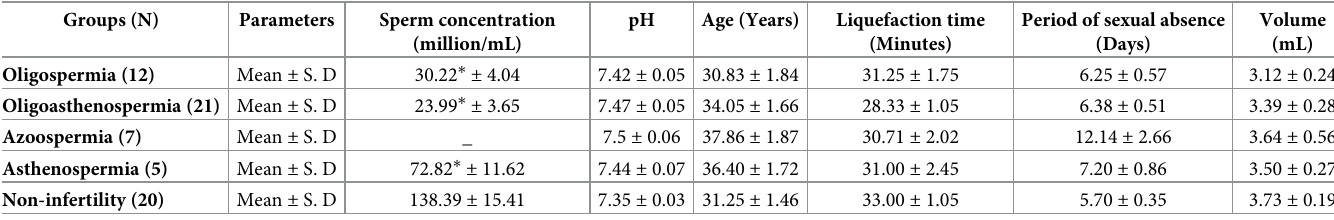
Table 2. Statistics of semen parameters for Infertile and non-infertile subjects.